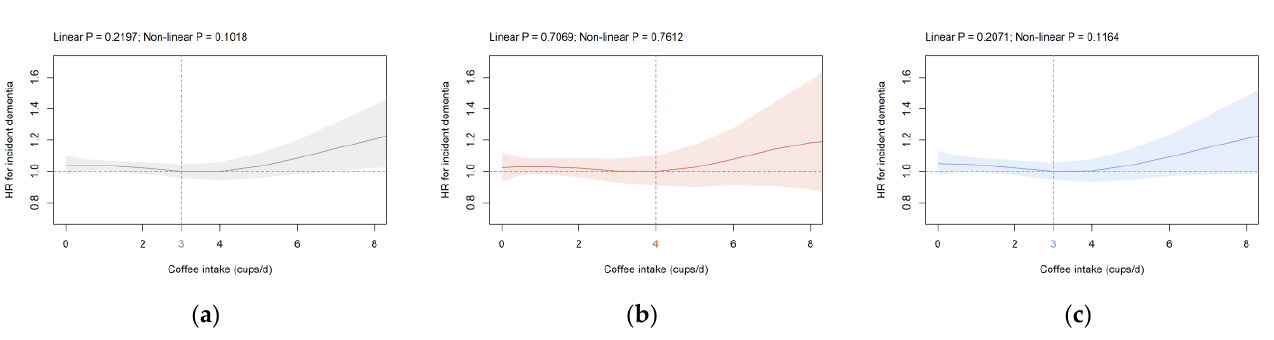
( c ) Figure 3. Association of coffee intake (cups/d) with dementia risk in the primary cohort in ( a ) all participants, ( b ) females, and ( c ) males. Data are adjusted and presented as indicated in Figure 1. Tea intake: In all participants and males, a significant U-shaped association was seen between tea intake and incident dementia (Figure 4a,c). HR 0 was significantly increased in all participants (1.23 (1.15, 1.32); Figure 4a) and males (1.31 (1.21, 1.43); Figure 4c). The nadir was at six cups/d for all participants and seven cups/d for males (Figure 4a,c). Sim- ilar findings were observed in all participants in cohorts S1 and S2 (data not shown), after removal of ICD-10 code G31 from the analysis (Supplementary Figure S3d), as well as after inclusion of age and percentage body fat as continuous instead of categorical param- eters (Supplementary Figure S4d).